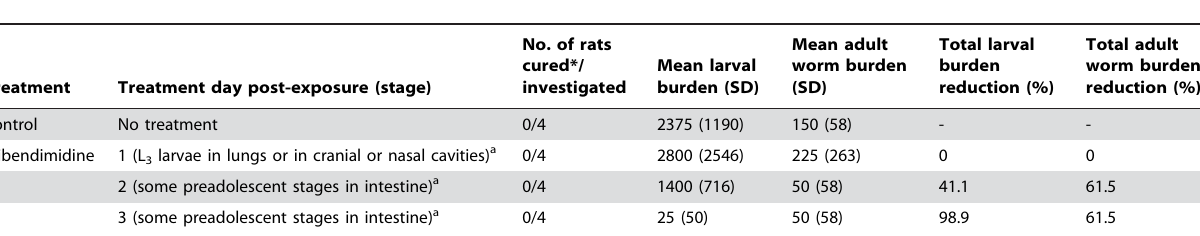
Table 3. Effect of a single 50 mg/kg oral dose of tribendimidine against immature stages of S. ratti harbored in rats.